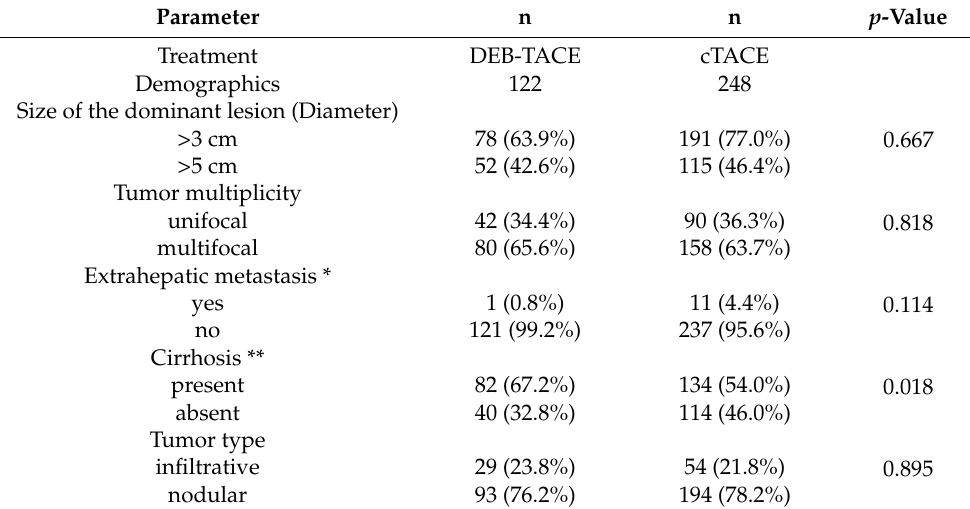
Table 2. Baseline tumor